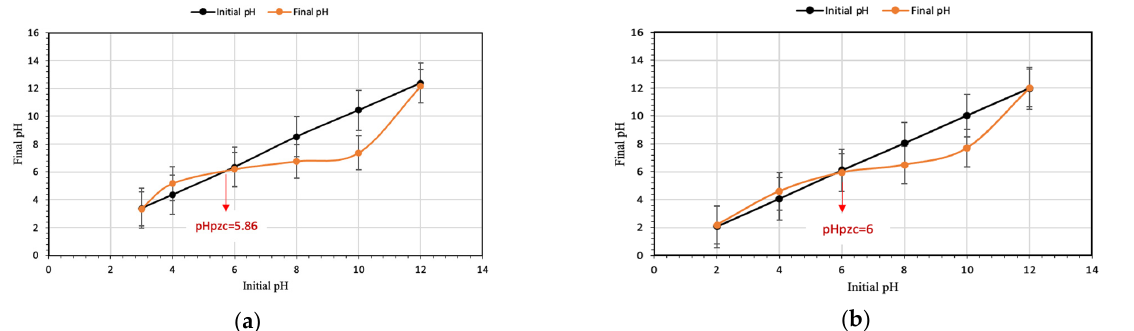
Figure 13. pH pzc plot of native starch ( a ) and St-g-(MA-DETA) ( b ).